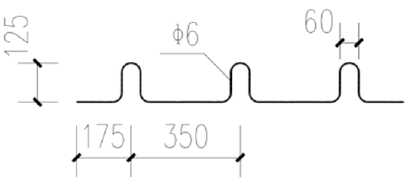
tion A-A of floor slab (unit: mm).